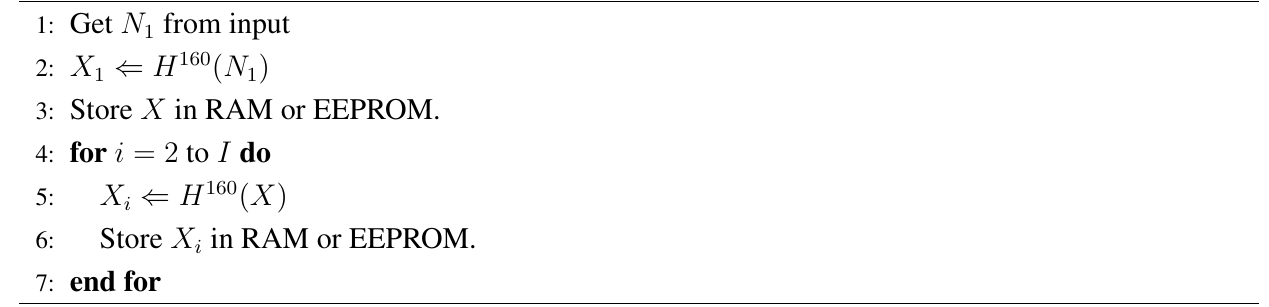
Algorithm 3 Temporary hash chain generation of a message-specific